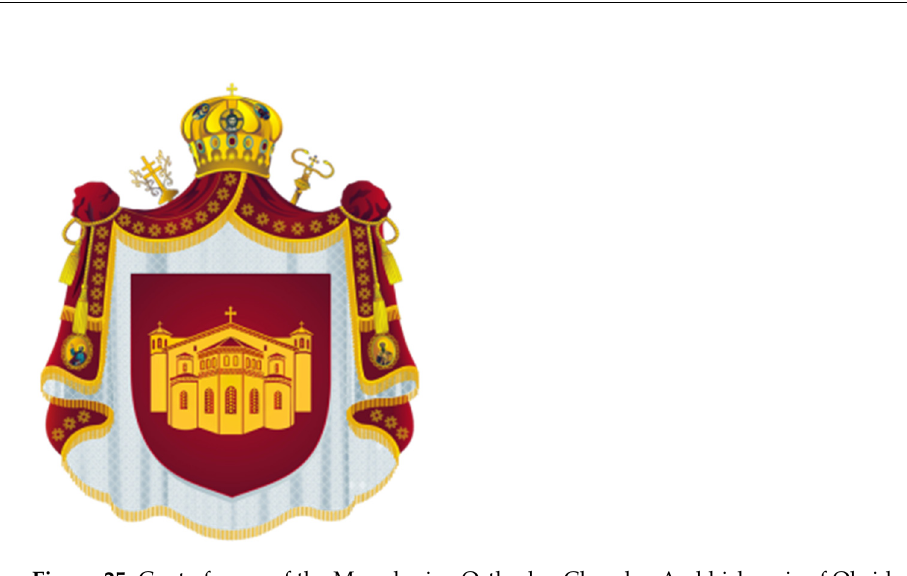
Figure 24. ( a ) Proposal for the arms of the President of the Republic of Macedonia; ( b ) Official arms of the President of the Republic of Macedonia.